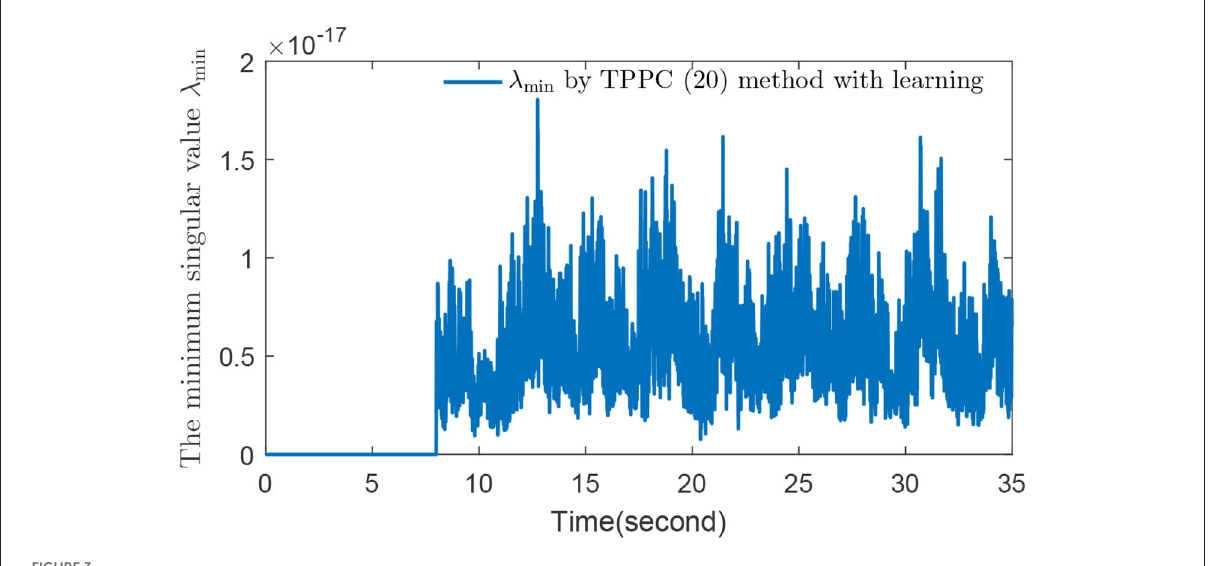
FIGURE3 The minimum singular value λ min of G ( t